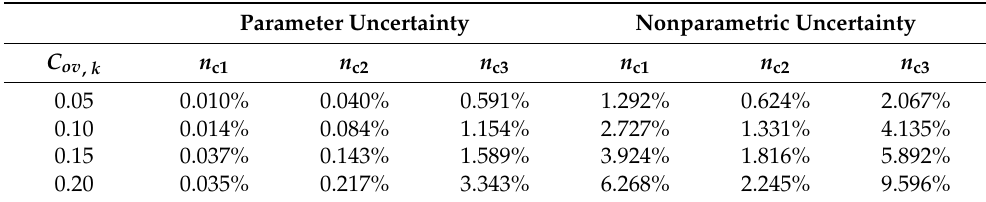
Figure 4. The first three-order critical speeds of the uncertain dual-rotor system for C ov,k , from 0 to 0.20. ( a ) The first-order critical speed. ( b ) The second-order critical speed. ( c ) The third-order critical speed. Table 2. Relative errors of the first three-order critical speeds of the system with two uncertainties at the intermediate support